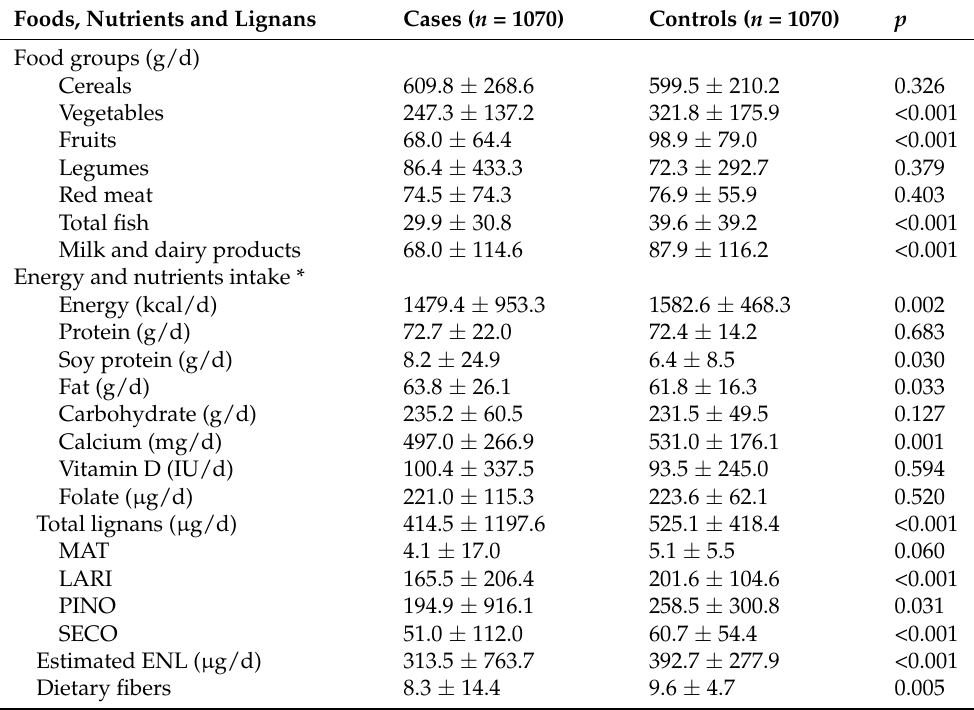
Table 2. Dietary intakes of foods and nutrients among cases patients and controls of Chinese elderly men and women, Guangzhou, China.